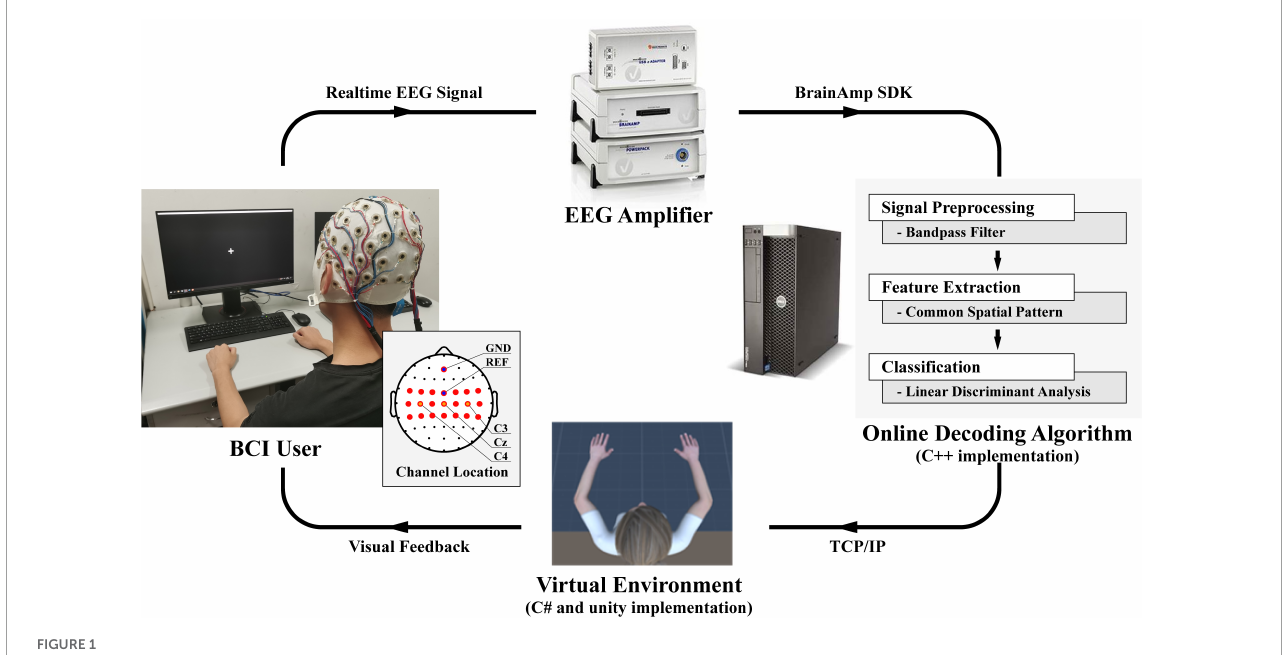
FIGURE1 The framework of the online platform of the BCI